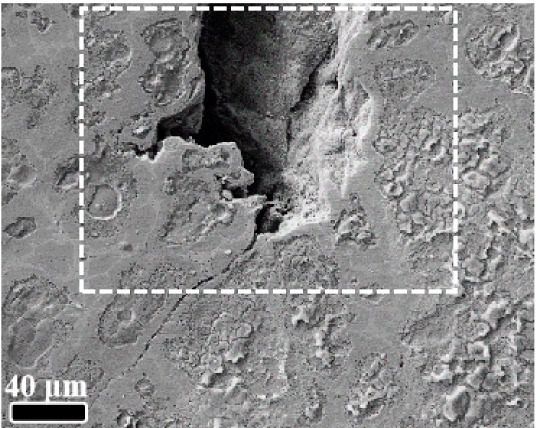
Figure 14. The SEM image of the cross-section of the tensile region around 1 mm beneath the fracture surface of Cu-12Sn-1.5Ni alloy